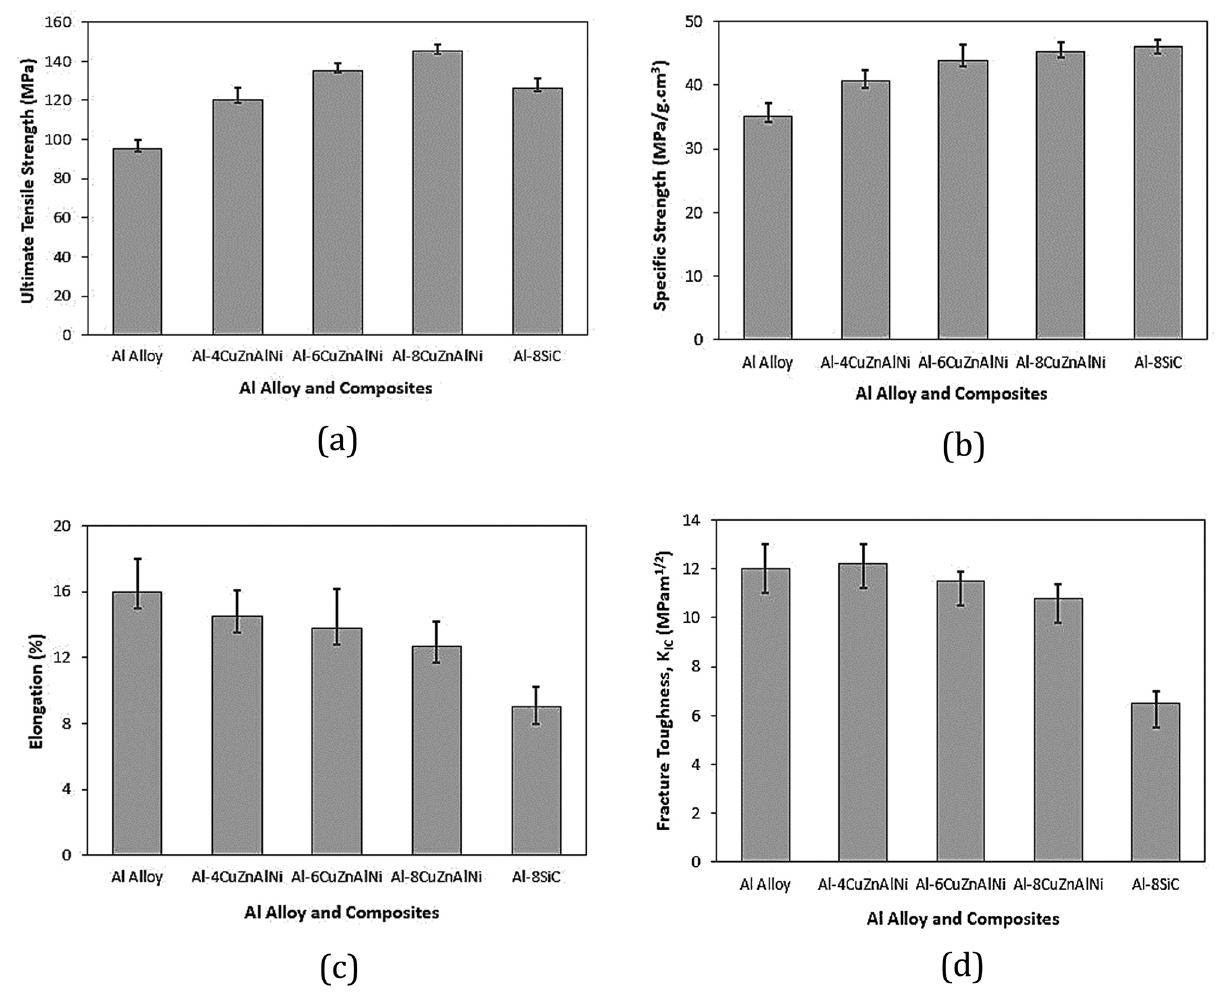
Figure 5: Showing variations in ( a ) ultimate tensile strength, ( b ) speci fi c strength, ( c ) % elongation, and ( d ) fracture toughness of the Al alloy and Al - based composites